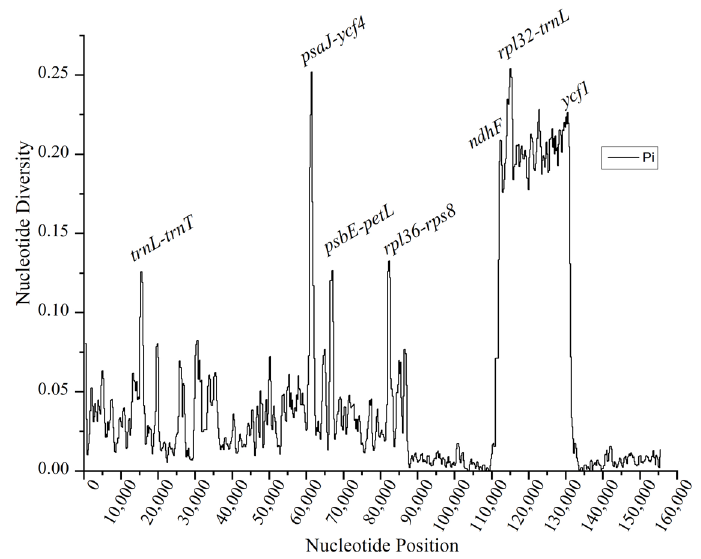
Figure 3. Nucleotide variability (Pi) values of the six Desmodieae chloroplast genomes using a sliding window analysis.